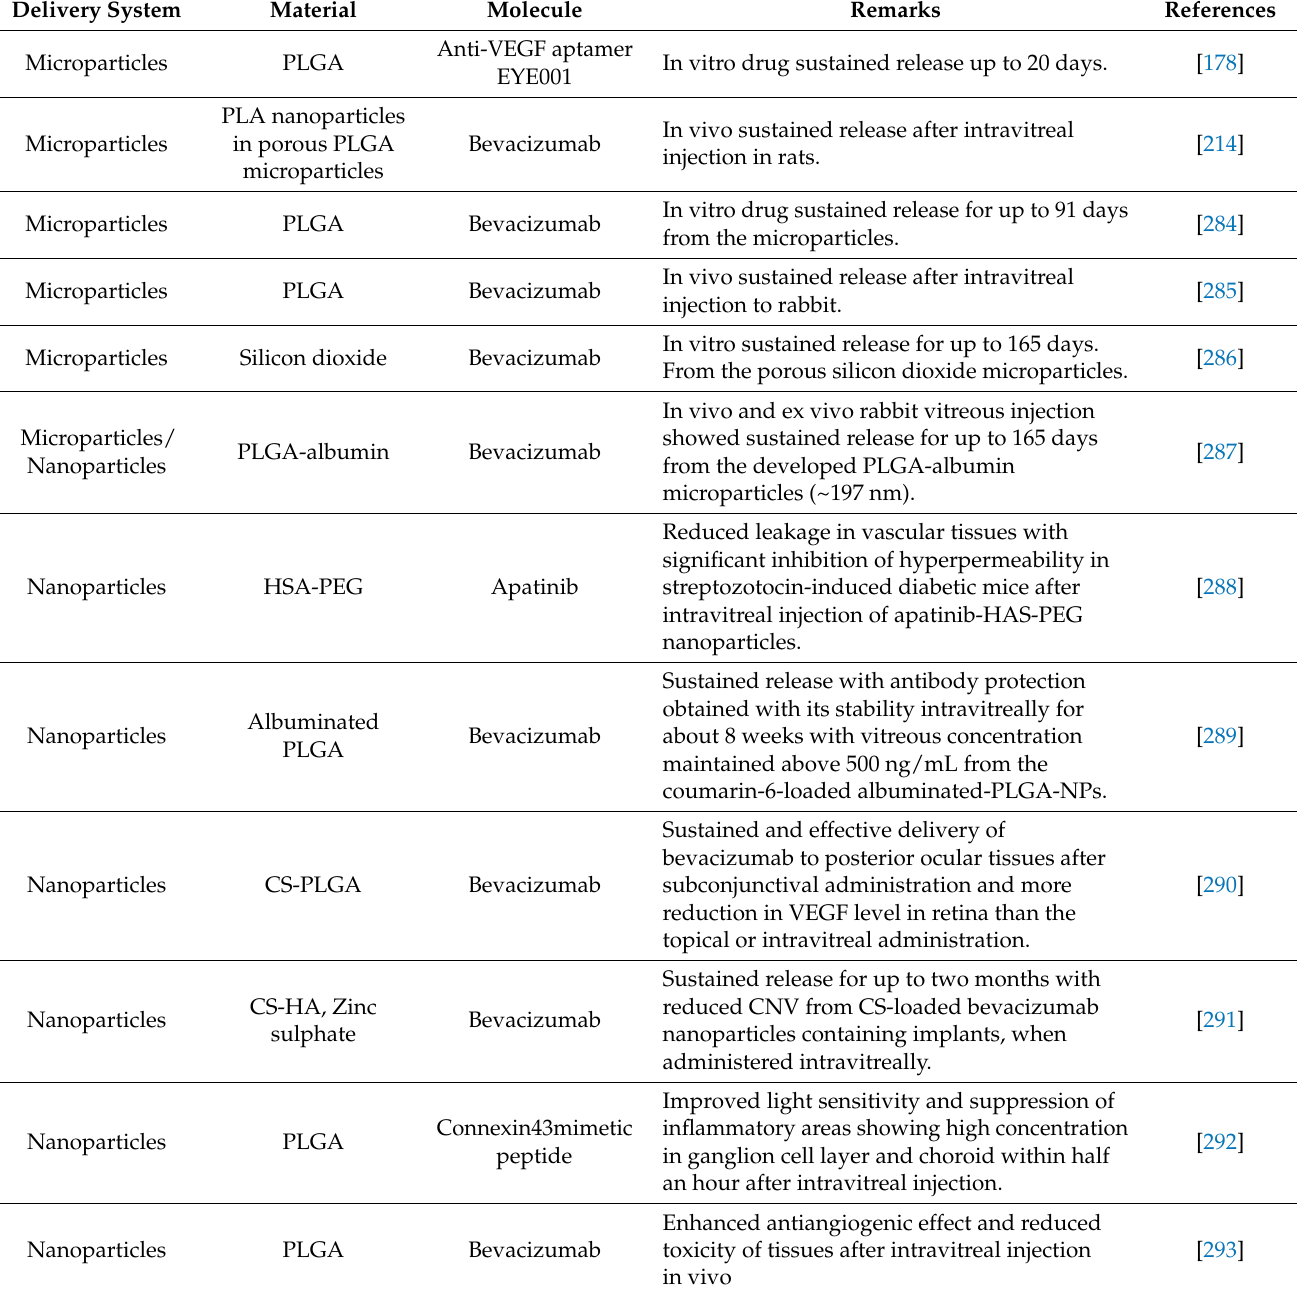
Table 3. Examples of the most relevant results obtained with different formulation approaches used to improve the ocular delivery of therapeutic